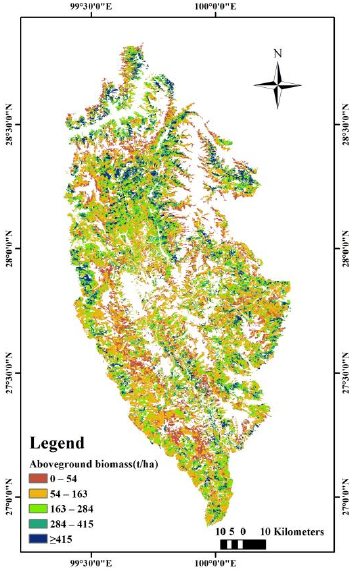
Figure 10. Aboveground biomass in Shangri-La City.